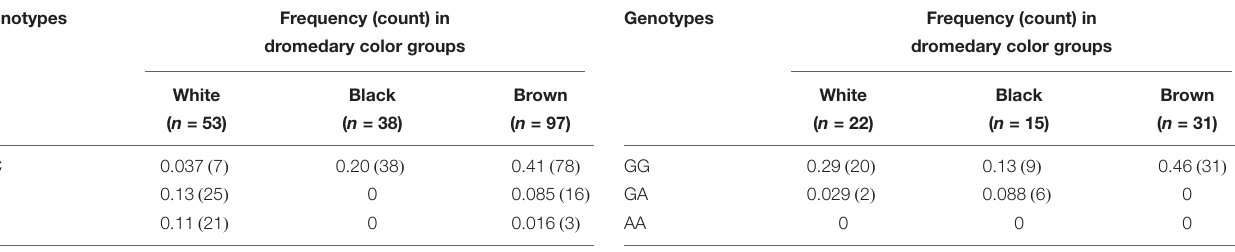
Frontiers in Genetics |